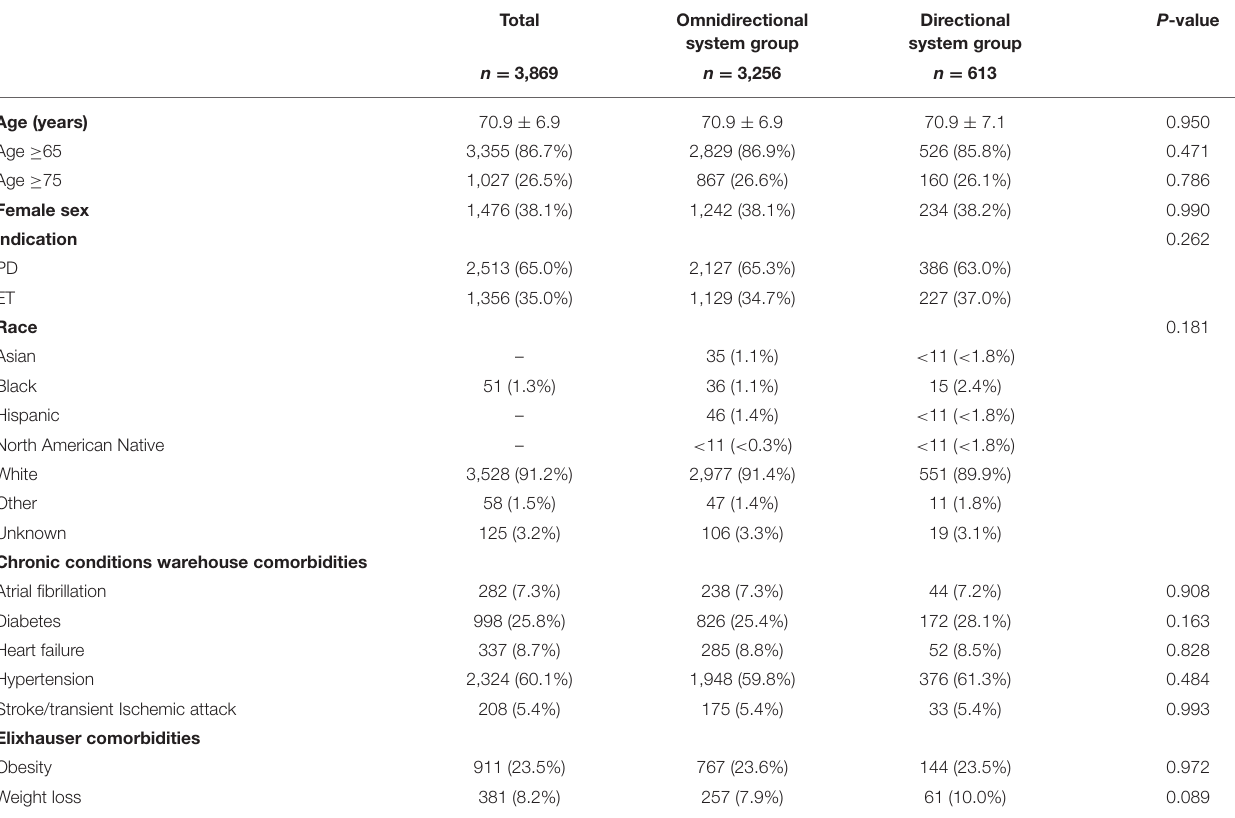
TABLE 2 | Patient demographics and selected comorbidities of clinical importance for the cohort and subgroups.